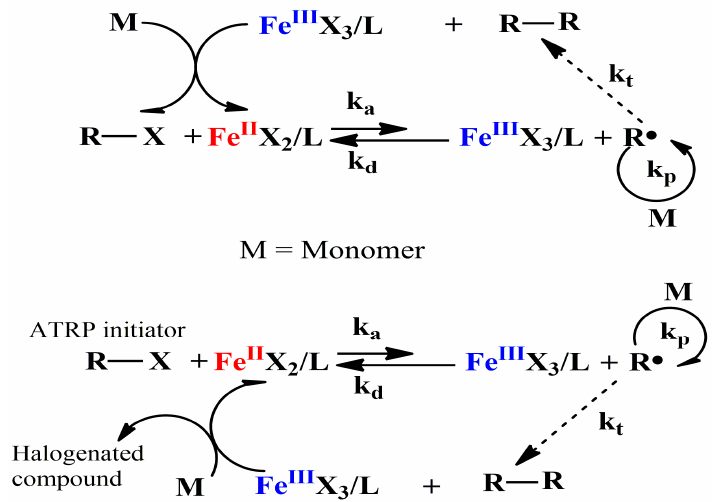
Figure 5. Mechanism of GAMA ATRP catalyzed by iron (III) catalyst.